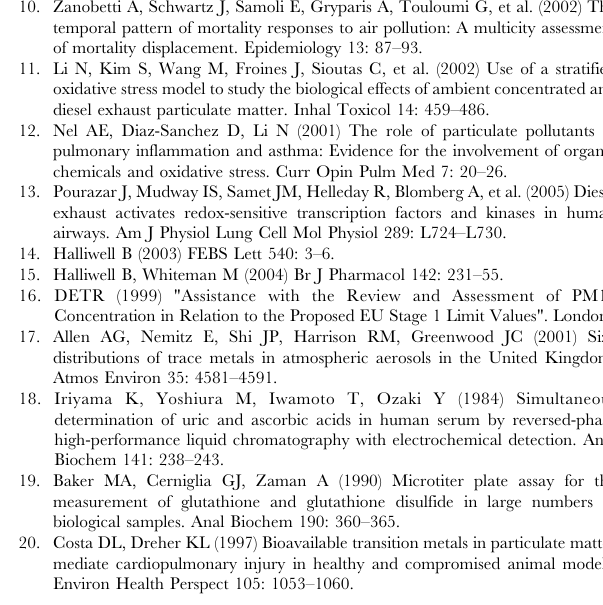
Figure S2 Mean size-fractionated PM trace metal (Ni, V, Zn) concentrations at primary school sampling sites. Each bar represents the mean of two filter samples per site visit with the associated standard deviation. Diamond markers indicate the mean total PM 10.2 trace metal concentration for each site. (TIF) Figure S3 Mean size-fractionated PM soluble inorganic constit- uent concentrations at primary school sampling sites. Each bar represents the mean of two filter samples per site visit with the associated standard deviation. Diamond markers indicate the mean total PM 10.2 soluble inorganic constituent concentration for each site. (TIF) Figure S4 Mean size-fractionated PM ascorbate and glutathione related oxidative potential at primary school sampling sites. Each bar represents the mean of two filter samples per site visit with the associated standard deviation. Diamond markers indicate the mean total PM 10.2 oxidative potential for each site. (TIF) Table S1 Bivariate correlation analysis for OP AA , OP GSH , mass concentration and metal variables expressed per unit volume in the top triangle (blue) and per unit mass in the bottom triangle (green) for PM 10.2 and individual PM size fractions (N= 14). Correlations with p values less than 0.01 and 0.05 are highlighted in yellow and orange,